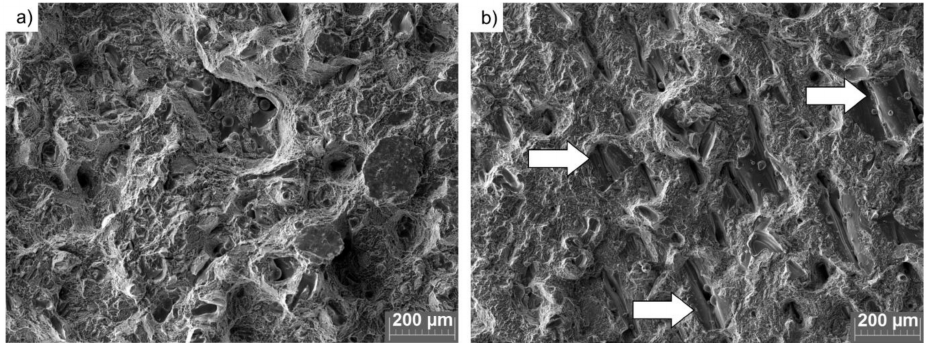
Figure 14. SEM photographs of fracture surfaces of tensile samples: ( a ) FRESH and ( b ) USED powders. The arrows indicate lack of fusion.